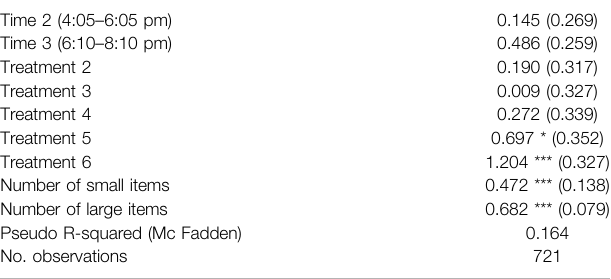
TABLE 3 | Regression results for accepted plastic bags (observation data). Time 2 (4:05 – 6:05